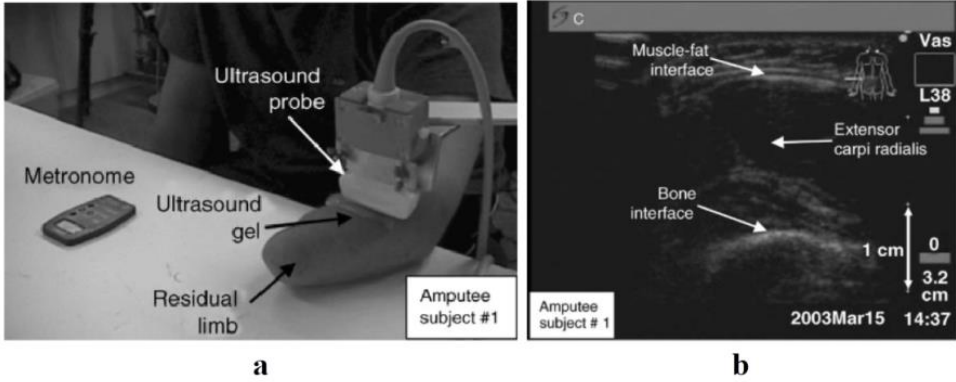
Figure 3. Collecting SMG signals from an amputee subject, using a B-mode SMG system [38]. ( a ) The experimental setup. ( b ) A typical B-mode image of the residual limb. A study by Shi et al. [56] analyzed the possibility of real-time control of a prosthetic hand with one degree of freedom, utilizing muscle thickness fluctuations recorded by a US probe. They investigated the feasibility of controlling a prosthetic hand, utilizing the extensor carpi radialis thickness deformation, and found that a 1-DOF prosthetic hand can be controlled by only one muscle of the forearm, using the SMG technique.